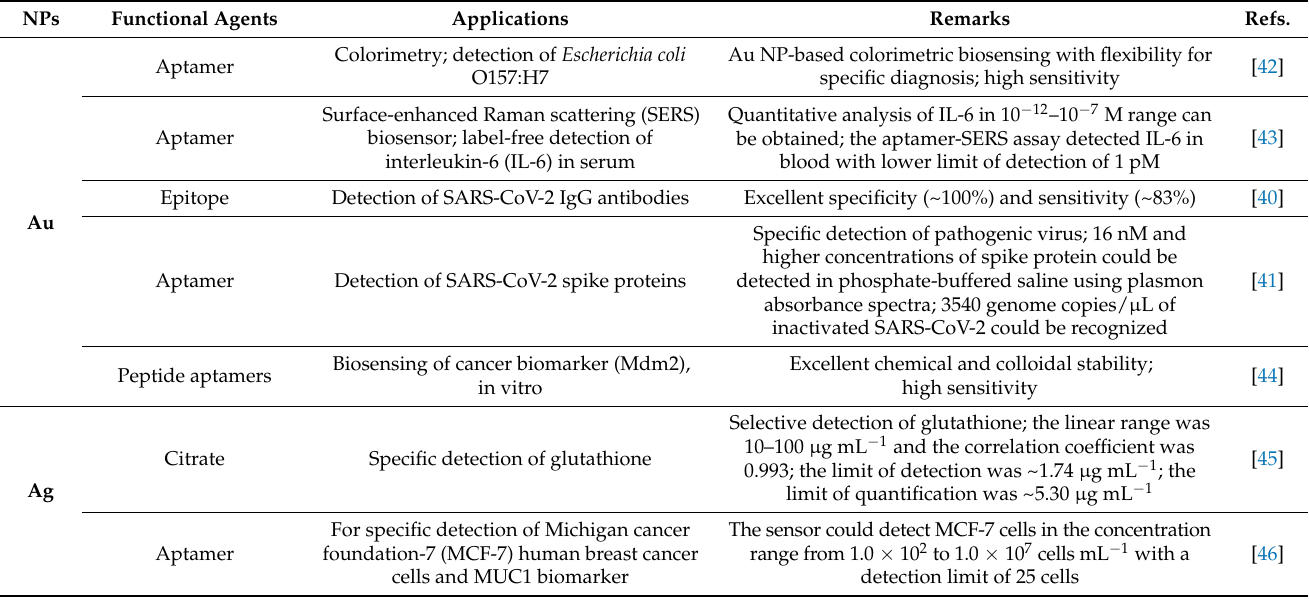
Table 2. Some selected examples of functionalized Ag and Au NPs with (bio)sensing